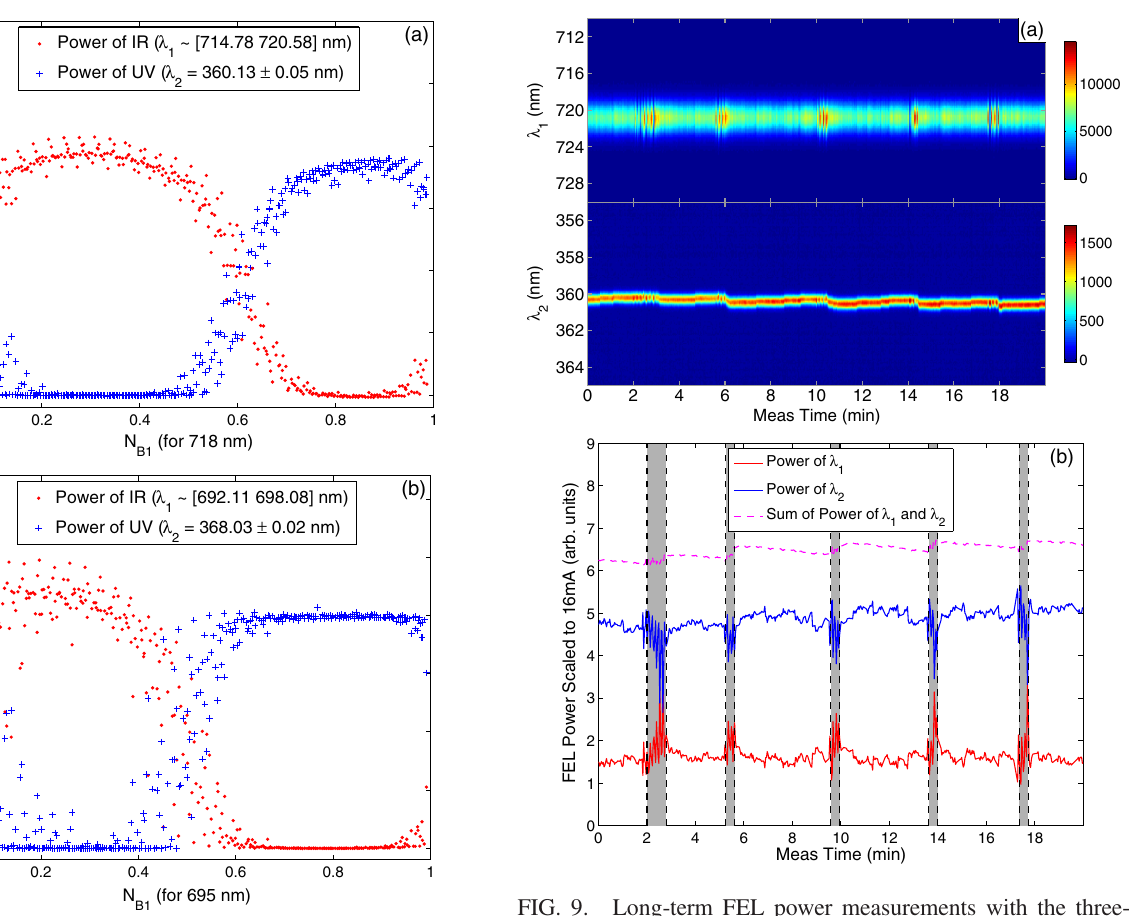
FIG. 8. Two-color FEL power control at two levels of cavity loss by tuning buncher B1 with the three-undulator configuration.